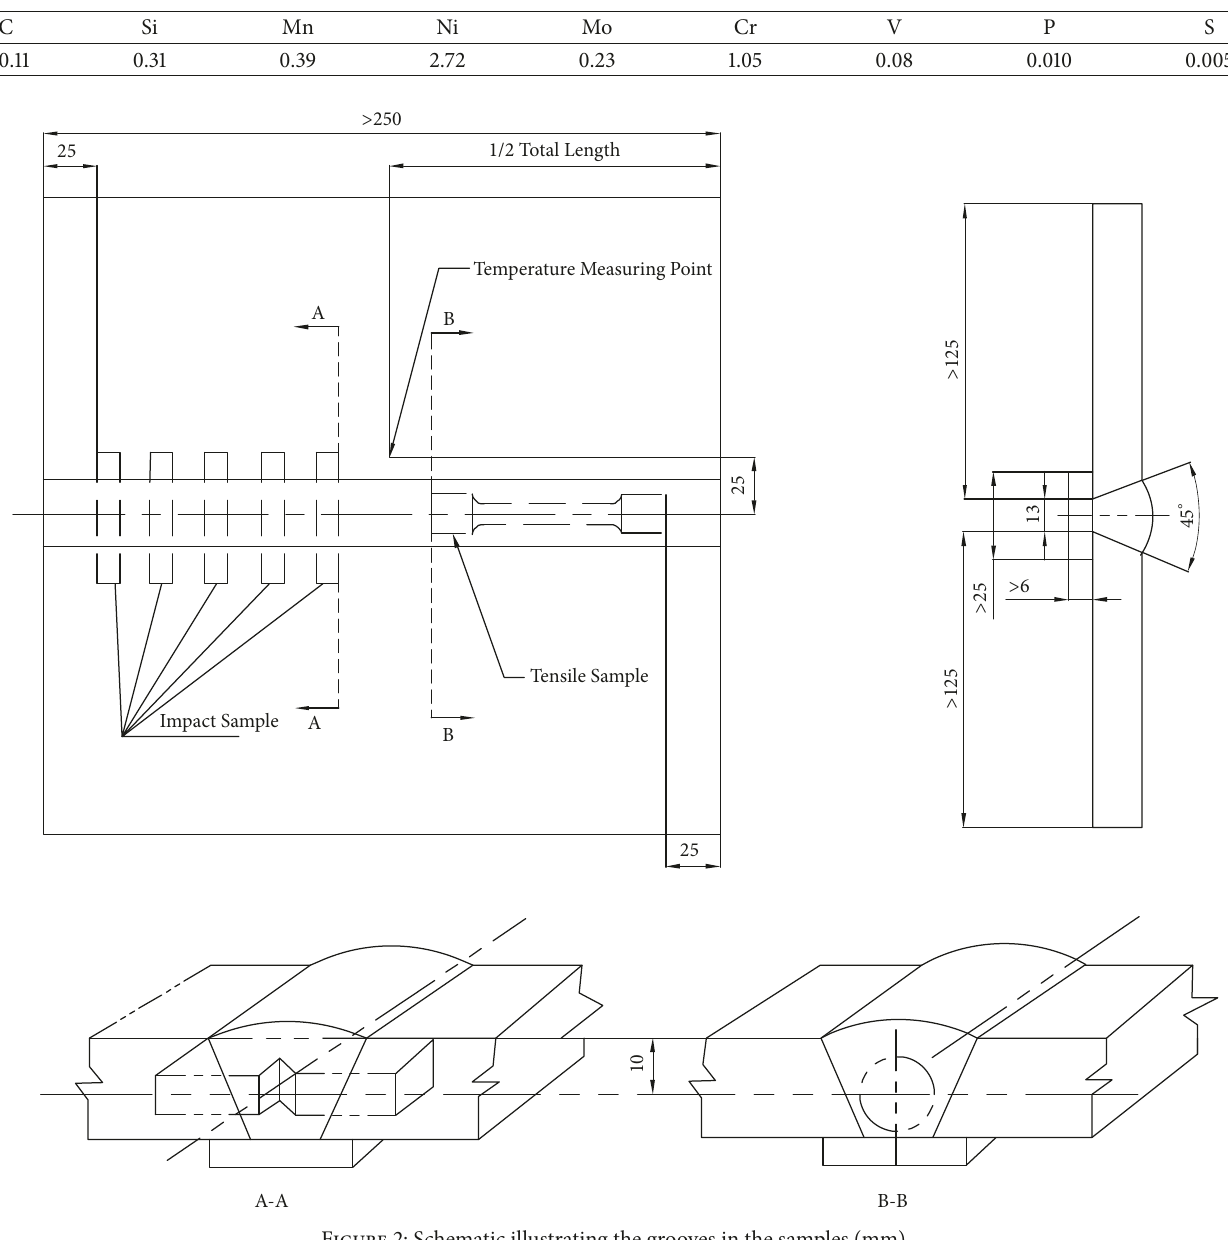
Table 3: Chemical composition of 10CrNi3MoV steel (wt. %).